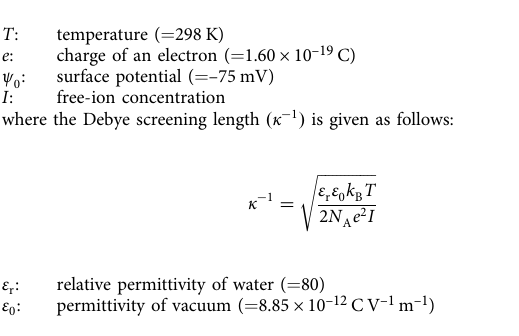
Fig. 5 Directional mass transport by the propagating wave. a Time- dependent 3D reconstructed CLSM images sectioned at z = 0.5 mm of a propagating wave (green) that transported polymer microparticles (red). A magnetically oriented TiNS dispersion ([TiNS] = 0.5 wt%; ~5 µ m in width, 0.75 nm in thickness) containing fl uorescently labeled polymer microparticles (10 µ m in diameter; CO 2 H modi fi ed) in a quartz cuvette (40 × 10 × 1 mm) was left at 25 °C in air (0.04% CO 2 ). 2D images were taken in a direction parallel to the xy -plane with a z -step size of 2 µ m to reconstruct 3D images, where TiNSs and the microparticles were visualized by re fl ection (488 nm laser) and fl uorescence (522 nm laser), respectively. b Typical trajectories of the microparticles at 10-min intervals obtained from time-dependent 2D cross-sectional CLSM images at z = 0.5 mm. c , d Histograms of the angle ( c ) and velocity ( d ) of microparticle transport, where the angle is given relative to the wave propagating